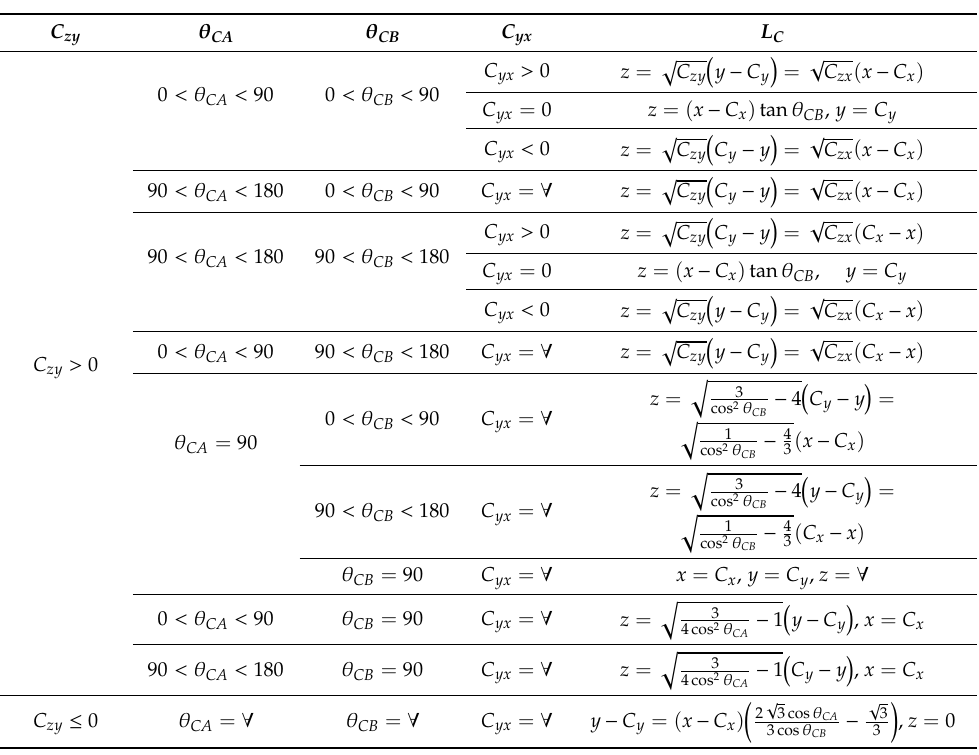
Table 2. Expressions of L C.